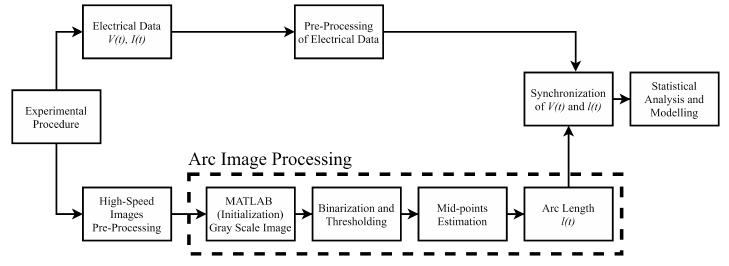
Figure 3. Block diagram of the data processing.